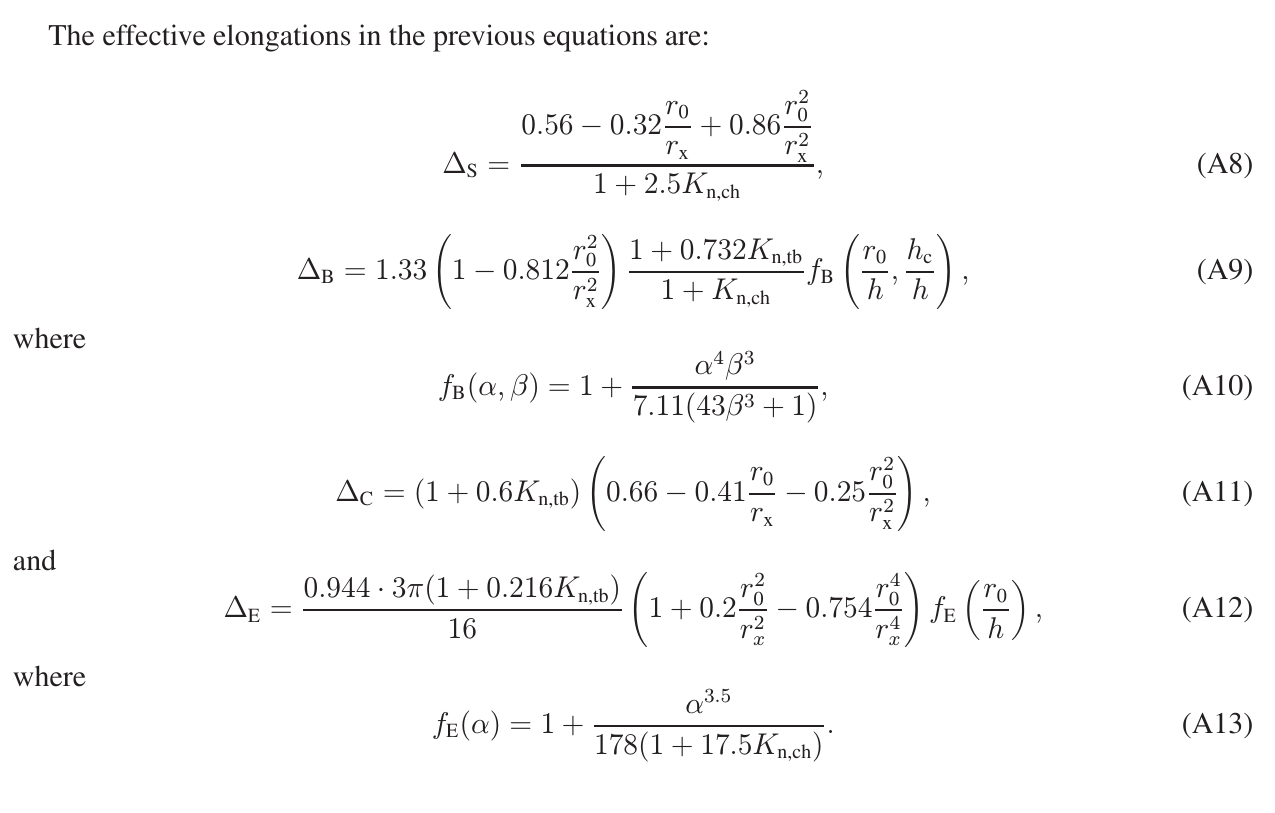
Figure 9 . Mechanical resistances used in modelling the fl ow in different regions of a perforation cell.